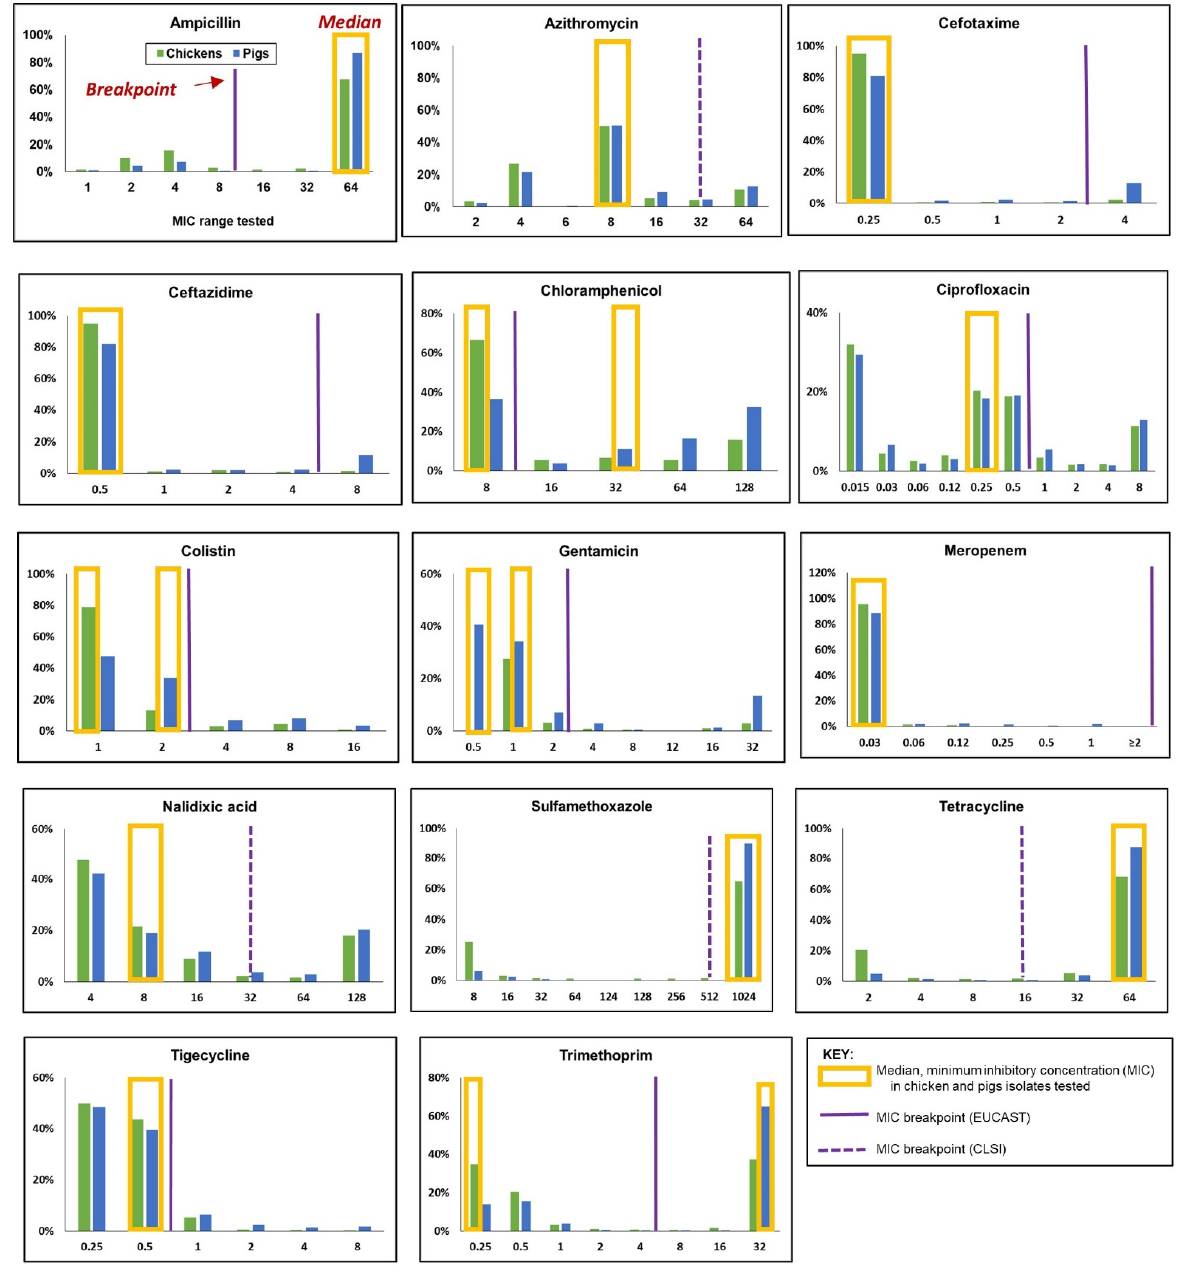
Figure 2. Distribution of minimum inhibitory concentration (MIC) in a panel of 14 antimicrobials, showing the relative locations of the clinical breakpoints and the median MIC values in Escherichia coli isolated from chickens ( n = 1110 isolates) and pigs ( n = 754).